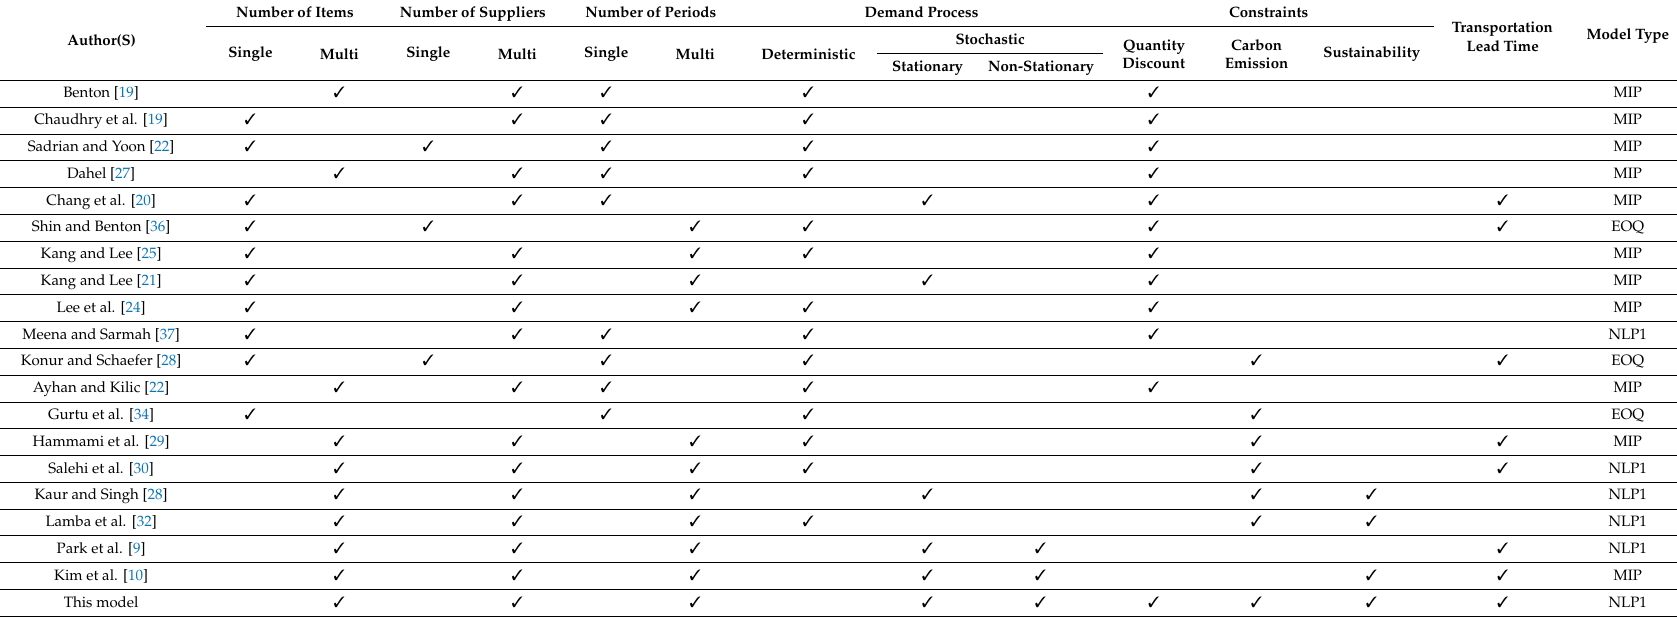
Table 1. Comparison of related studies regarding the inventory problem under various